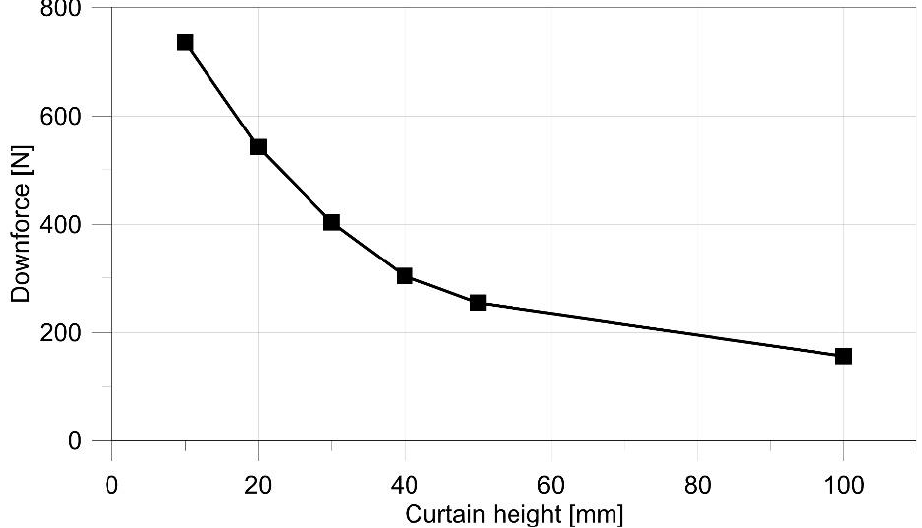
Figure 5. Variation of generated downforce with constant fan pressure in function of the curtain